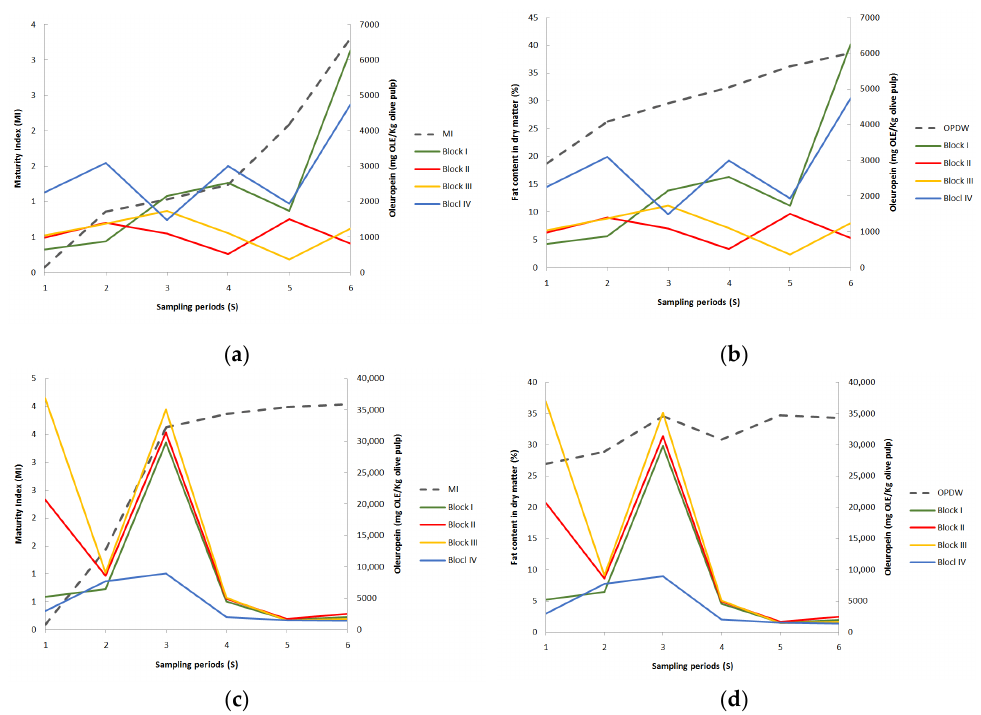
Figure 5. Ripening stage (S) profile of oleuropein (OLE) concentration regarding maturity index (MI) for ‘Cobrançosa’ ( a ) and ‘Galega Vulgar’ ( c ), and fat content in dry matter (OPDW) for ‘Cobrançosa’ ( b ) and ‘Galega Vulgar’ ( d ).